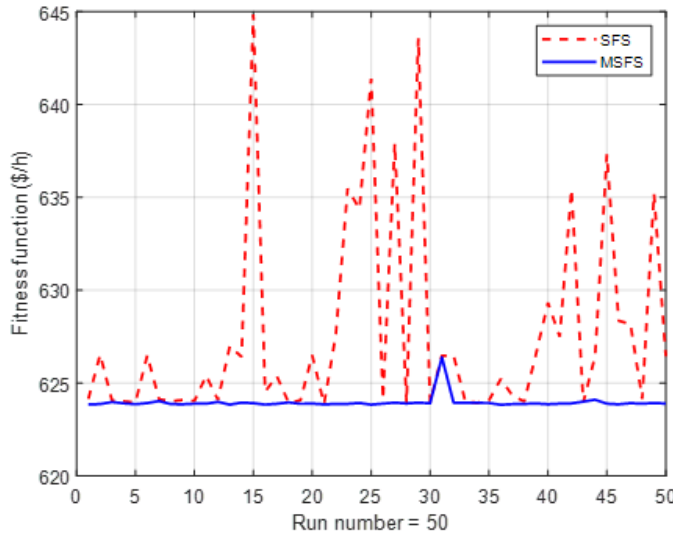
Figure 8. Distribution of 50 runs obtained by SFS and MSFS for case 11.